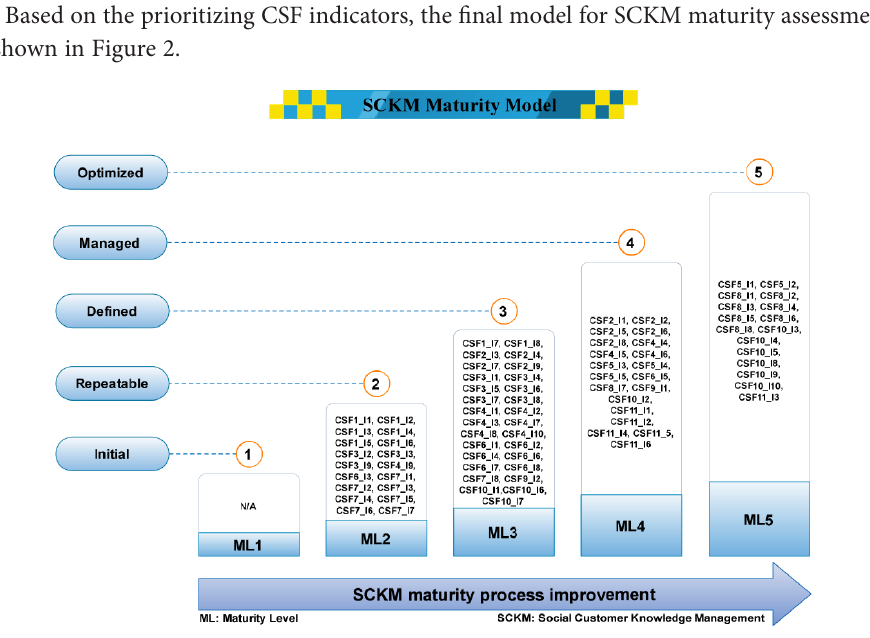
Figure 2. The final model for maturity assessment via disaggregated